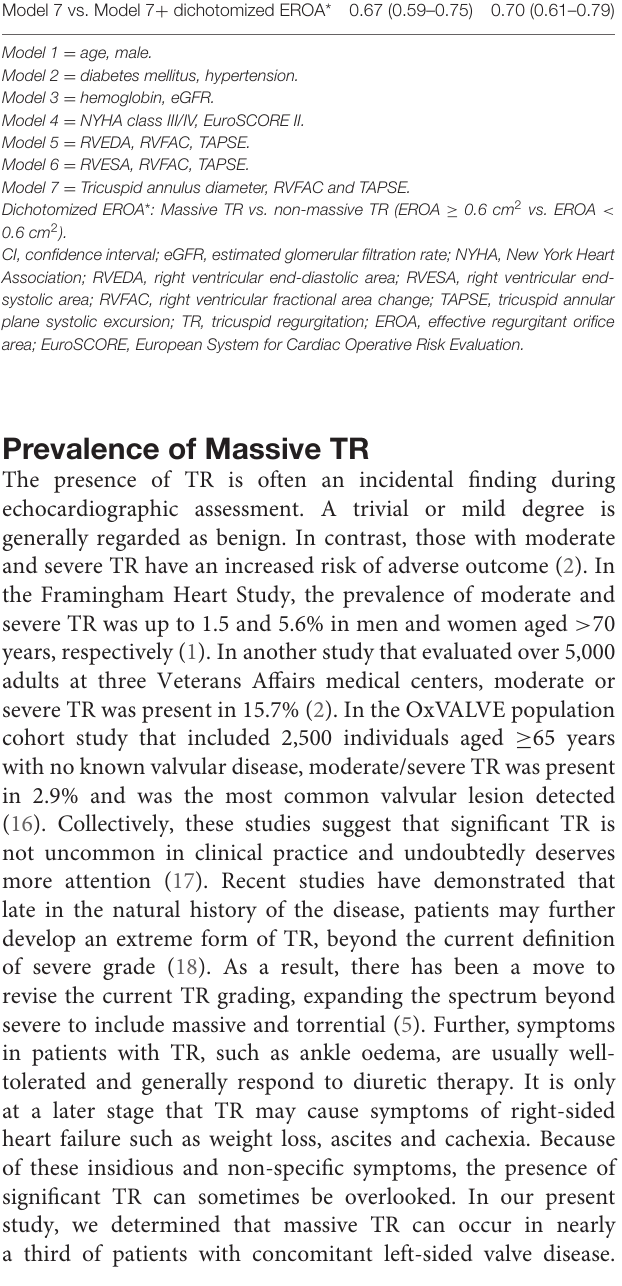
Association; RVEDA, right ventricular end-diastolic area; RVESA, right ventricular end- systolic area; RVFAC, right ventricular fractional area change; TAPSE, tricuspid annular plane systolic excursion; TR, tricuspid regurgitation; EROA, effective regurgitant orifice area; EuroSCORE, European System for Cardiac Operative Risk